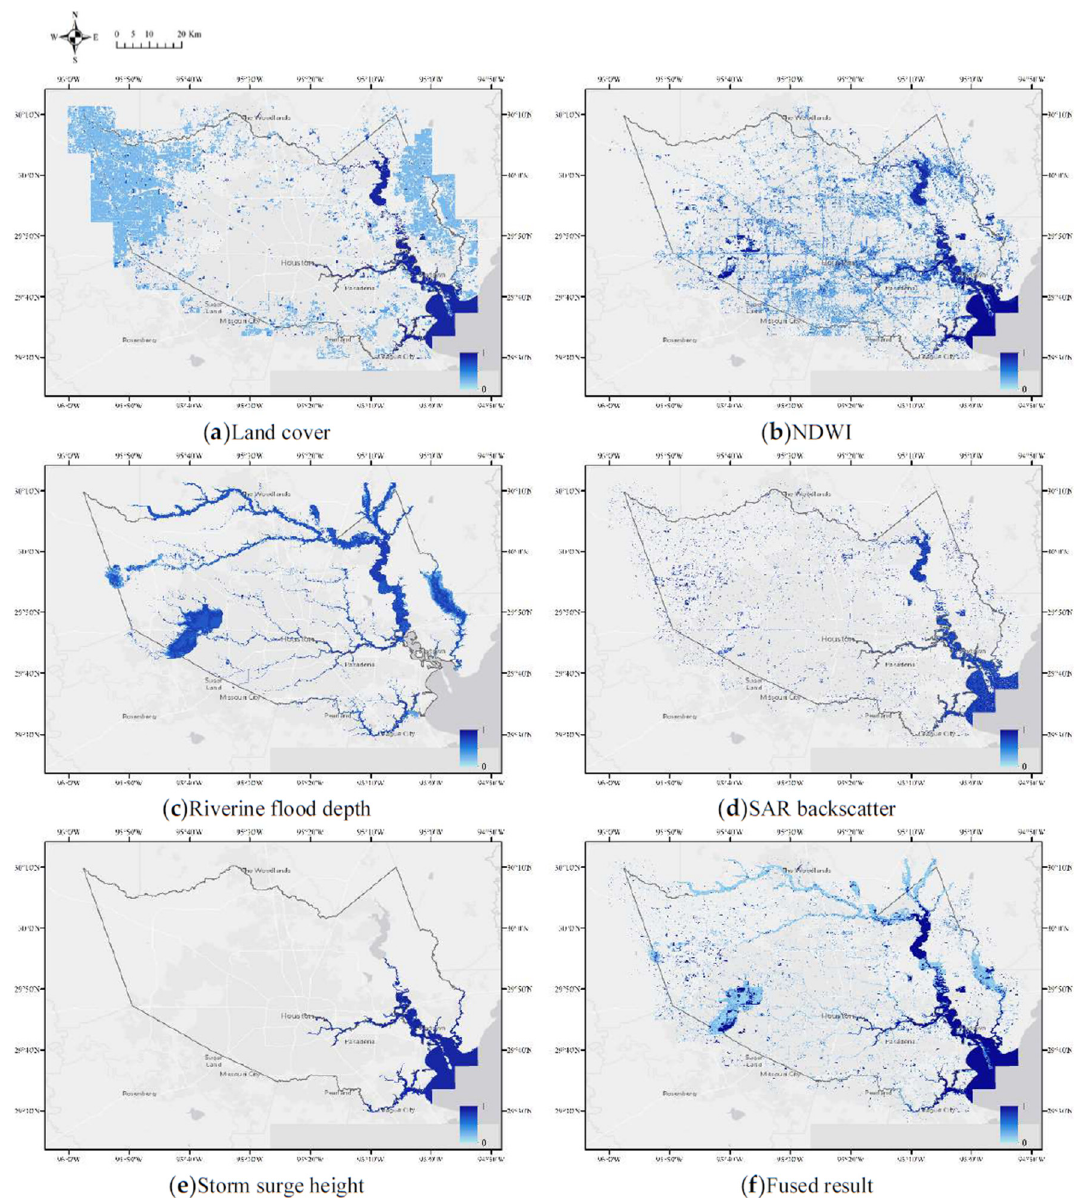
Figure 20. ( a – f ) Estimated inundation probability using single and fused components.